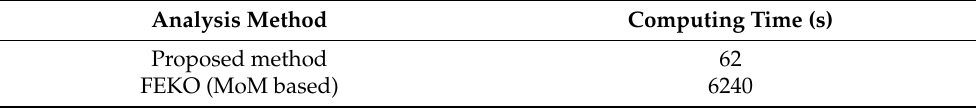
Table 2. Comparison of the computing time between the proposed method and